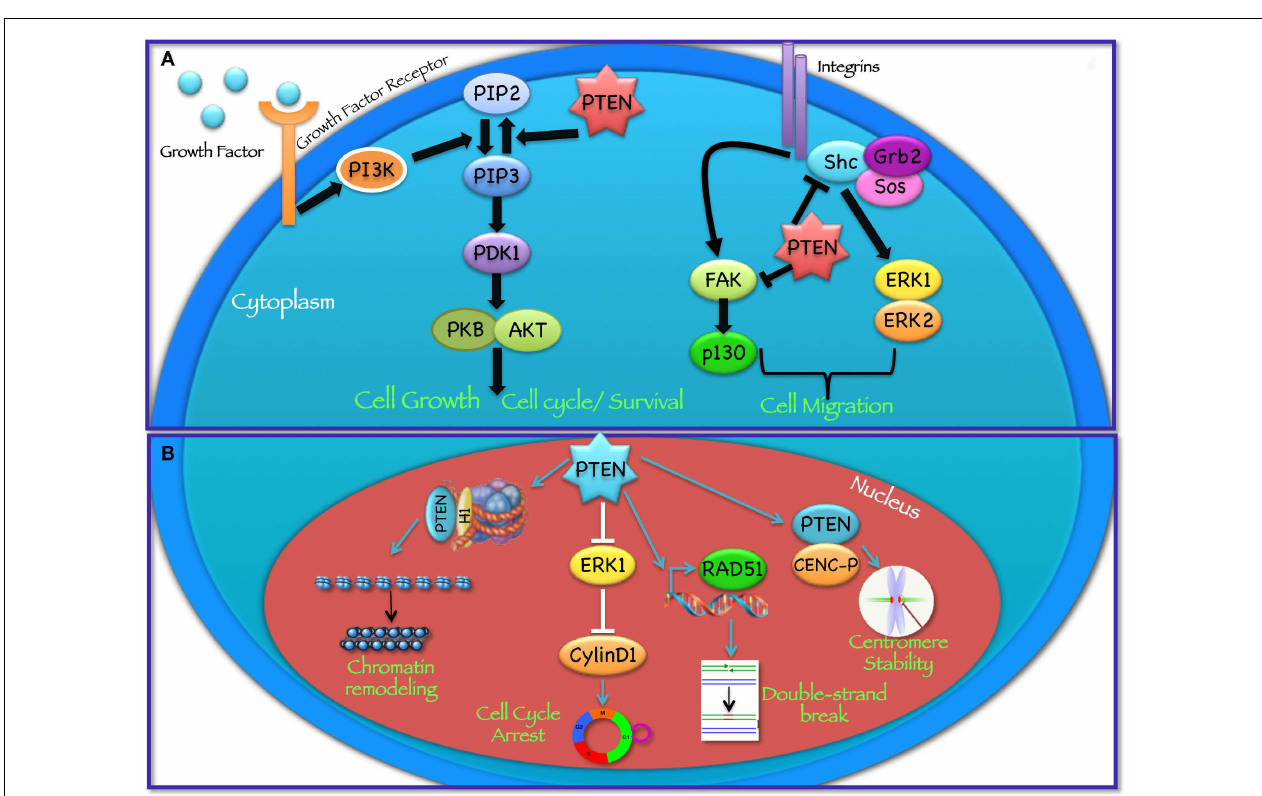
phosphatase activity directed against FAK and SHC, PTEN modulates complex pathways affecting cell migration. (B) In the nucleus, PTEN cooperates in maintaining genomic integrity, repairing DNA double-strand breaks, controlling homologous recombination, and promoting ubiquitin-dependent degradation of oncoproteins such as PLK1 and AURK. In addition, PTEN controls cell-cycle progression by modulating ERK phosphorylation and cyclin D1 levels and regulates chromatin remodeling by binding to histone